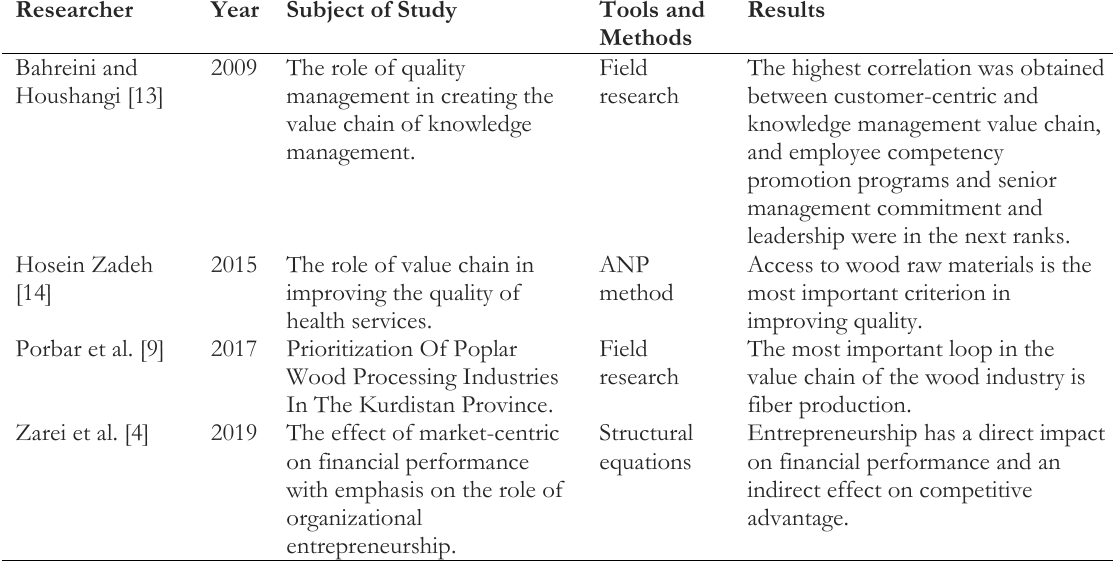
Table 1. Summary of research